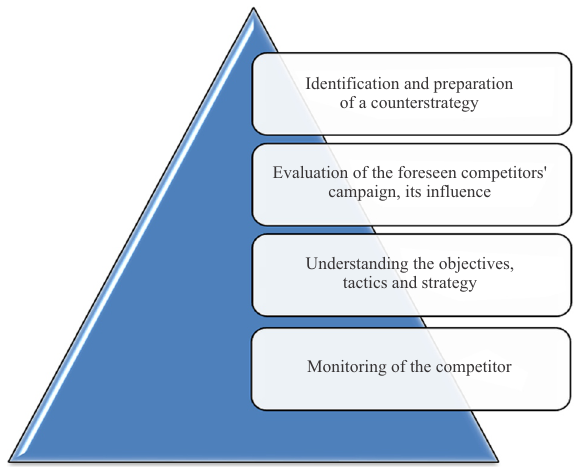
Fig. 2. The stages of preparation of the counter-strategy Source : Lisitsa